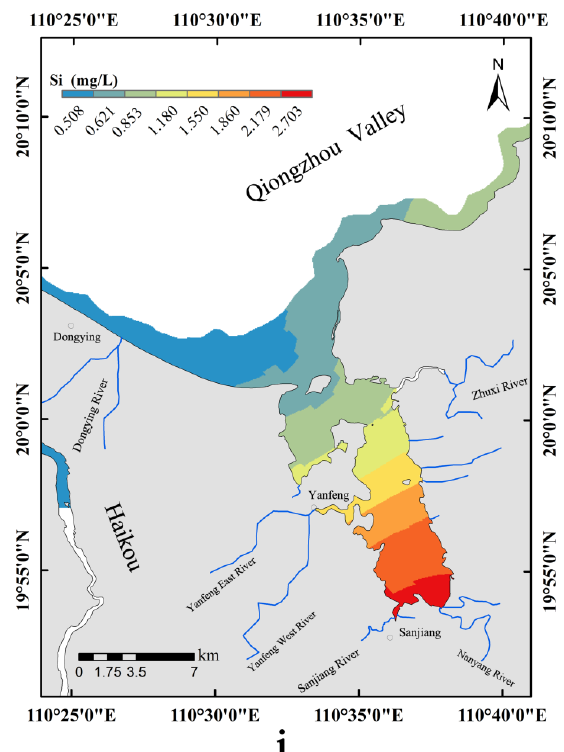
Figure 3. Spatial distribution of nutrients. ( a ) Spatial distribution of PO 43 − –P; ( b ) spatial distribution of PO 43 − ; ( c ) spatial distribution of NO 3 − –N; ( d ) spatial distribution of NO 3 − ; ( e ) spatial distribution of NH 3 –N; ( f ) spatial distribution of NH 4+ ; ( g ) spatial distribution of NO 2 − –N; ( h ) spatial distribution of NO 2 − ; ( i ) spatial distribution of